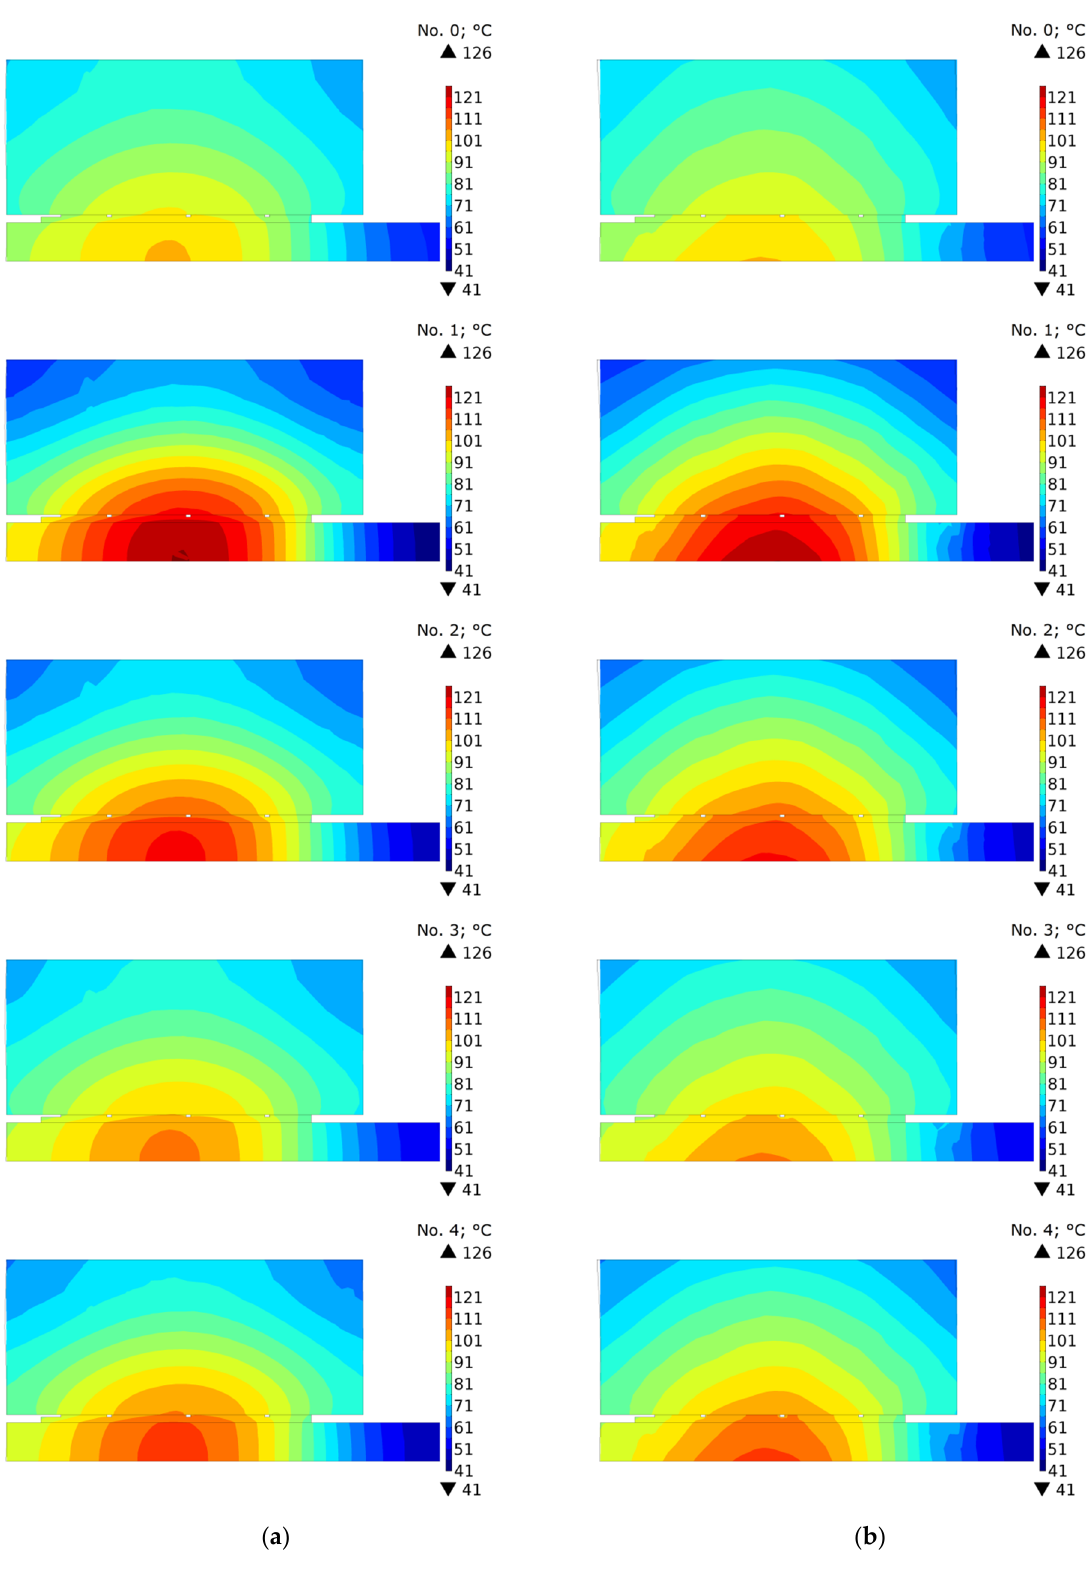
t obtained using: ( a ) connected [6]; and ( b ) dis- Figure 8. Temperature distribution at time + 0 s Figure 8. Temperature distribution at time t s + 0 s obtained using: ( a ) connected [6]; and ( b ) discon- s connected parts of the clutch for materials no. 0, 1, 2, 3, 4. nected parts of the clutch for materials no. 0, 1, 2, 3,